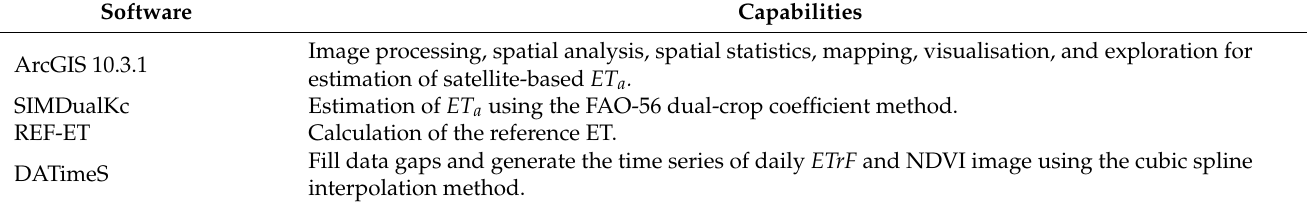
Table 4. Software used in this study.